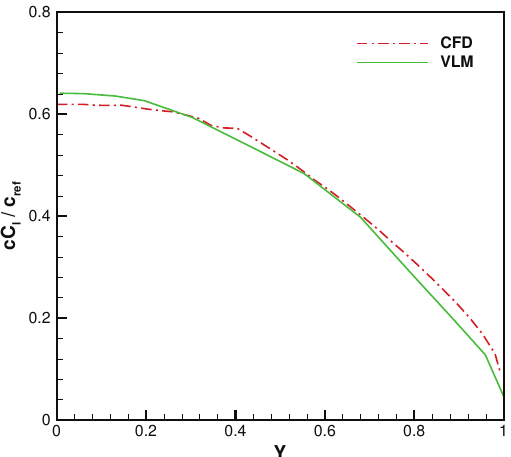
Figure 11. Clean configuration: spanwise loading distribution on isolated wing, for CFD and VLM